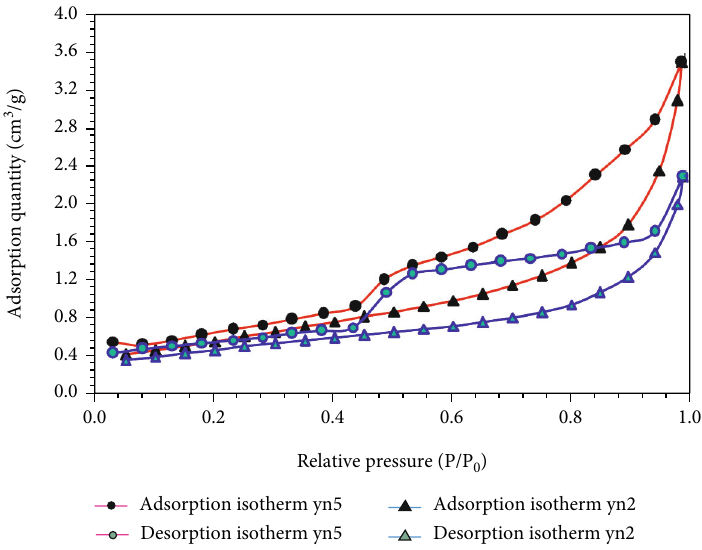
02468101214161820